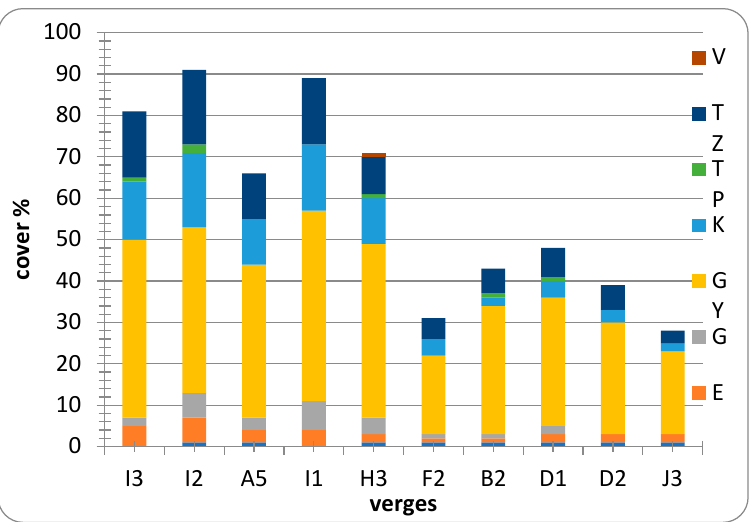
Figure 3. Distribution of species in the ten selected verges according to the nature conservation value categories of Simon. V: protected species; TZ: disturbance tolerants; TP: natural pioneers; K: supporting taxa; GY: weeds; G: generalists; E: constant species; A: adventives.